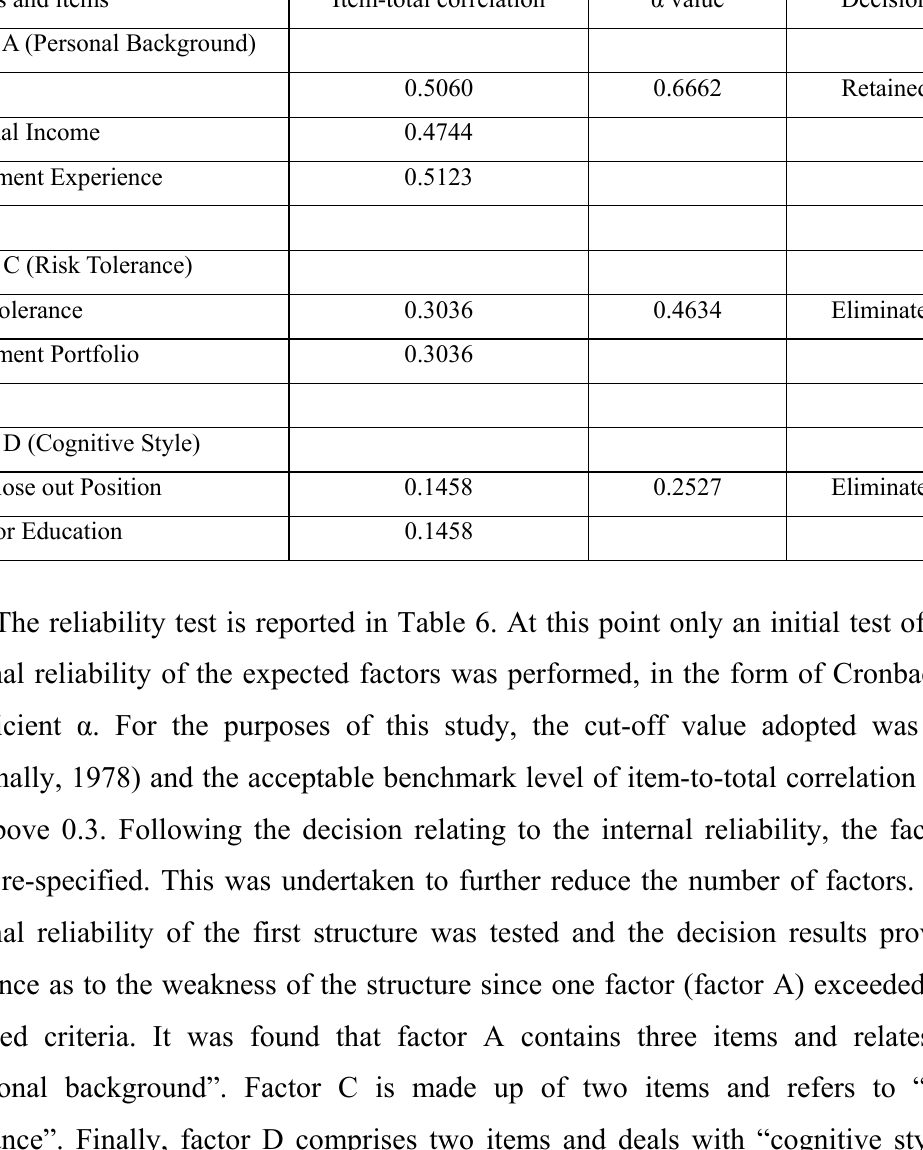
Table 6: Internal consistency and related decisions of first structure Factors and